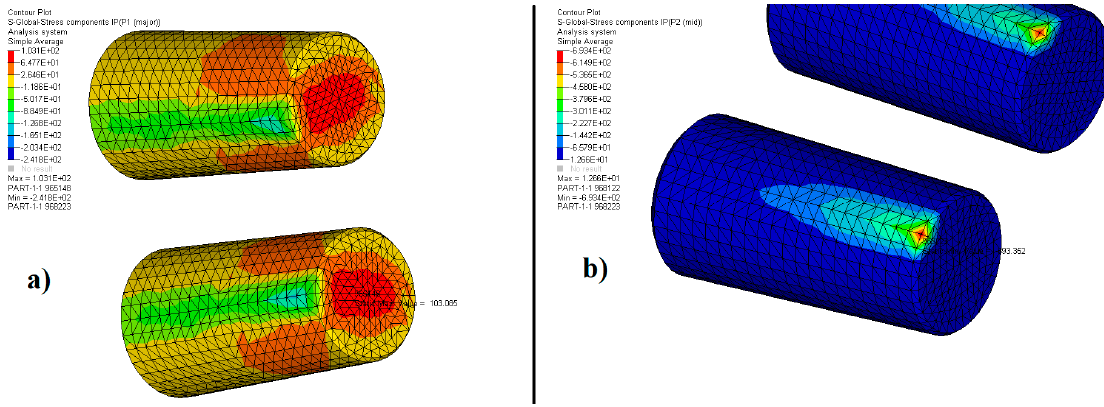
Figure 4. Distribution of the ( a ) first and ( b ) second principal stress-outer ring.